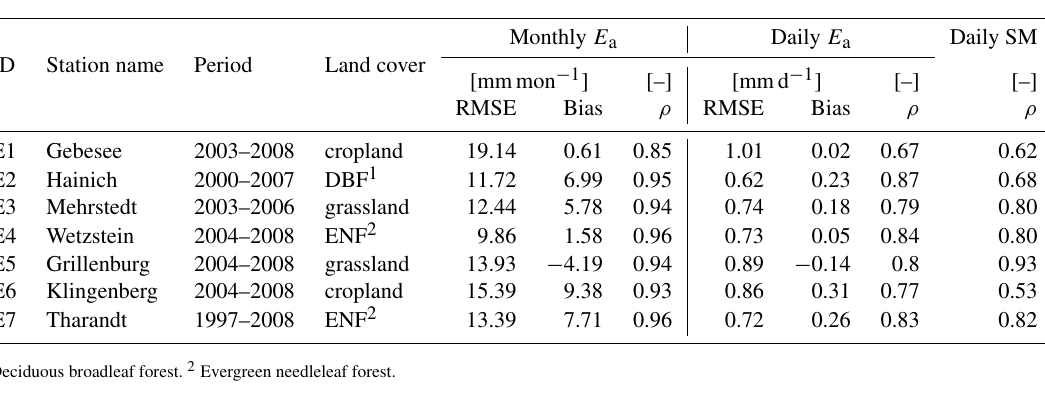
Table 2. Evaluation of evapotranspiration E a and soil moisture SM at seven eddy covariance stations. The evaluation is based on daily and monthly values for the available observation period. The location of the eddy stations is depicted in Fig. 1. Abbreviations: RMSE – root